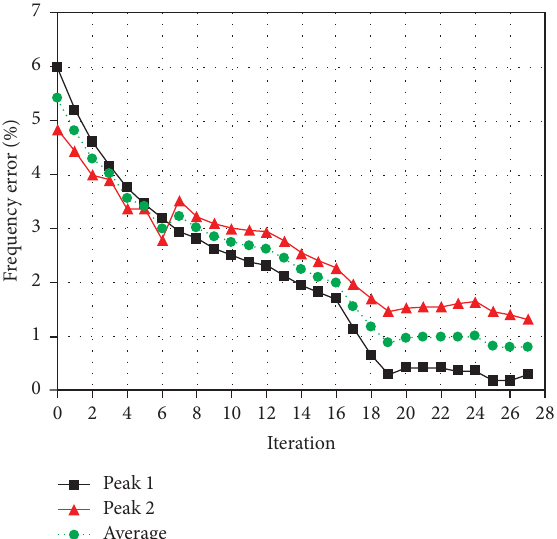
Figure 10: Convergences of the two peak frequencies of the FE model.